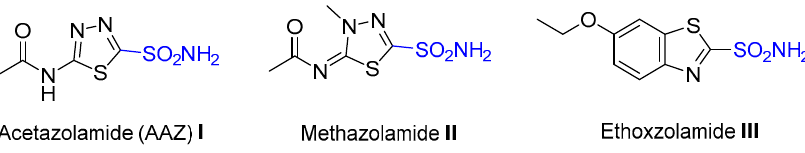
Figure 1. Chemical structures of some clinically used sulfonamide-containing drugs.